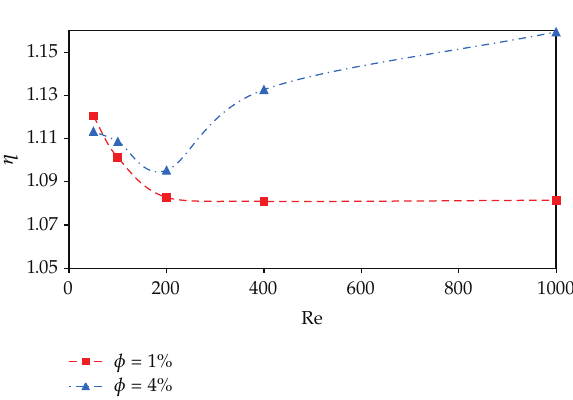
Figure 13: E ff ect of parameters φ and Re on η .